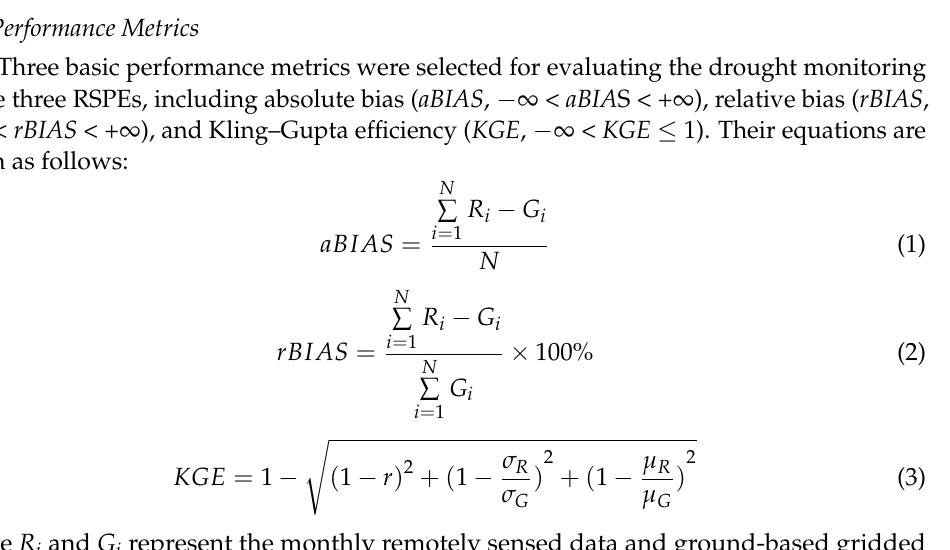
Figure 2. The methodological framework for evaluating the drought performance of the three long-term remotely sensed precipitation estimates.